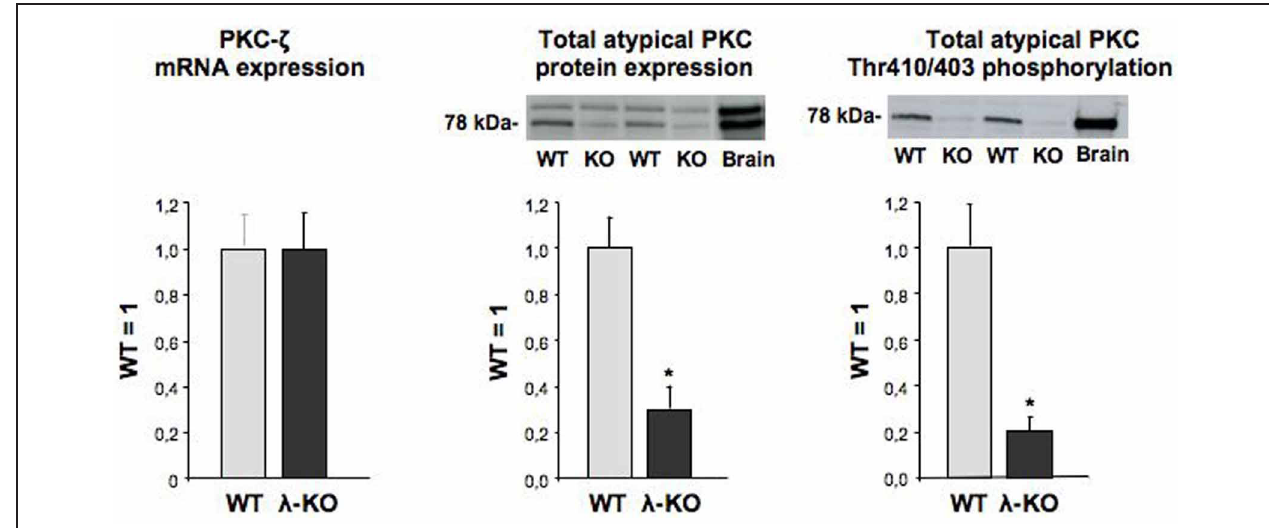
WesterndetectionoftotalatypicalPKCexpressionandphosphorylation(middle andrightgraph).IncaseofWesterndetection,representativeblotsaredisplayed above each graph. Data are means ± SEM for six experiments carried out with different heart homogenates. ∗ Significantly different from WT ( P < 0 . 05).